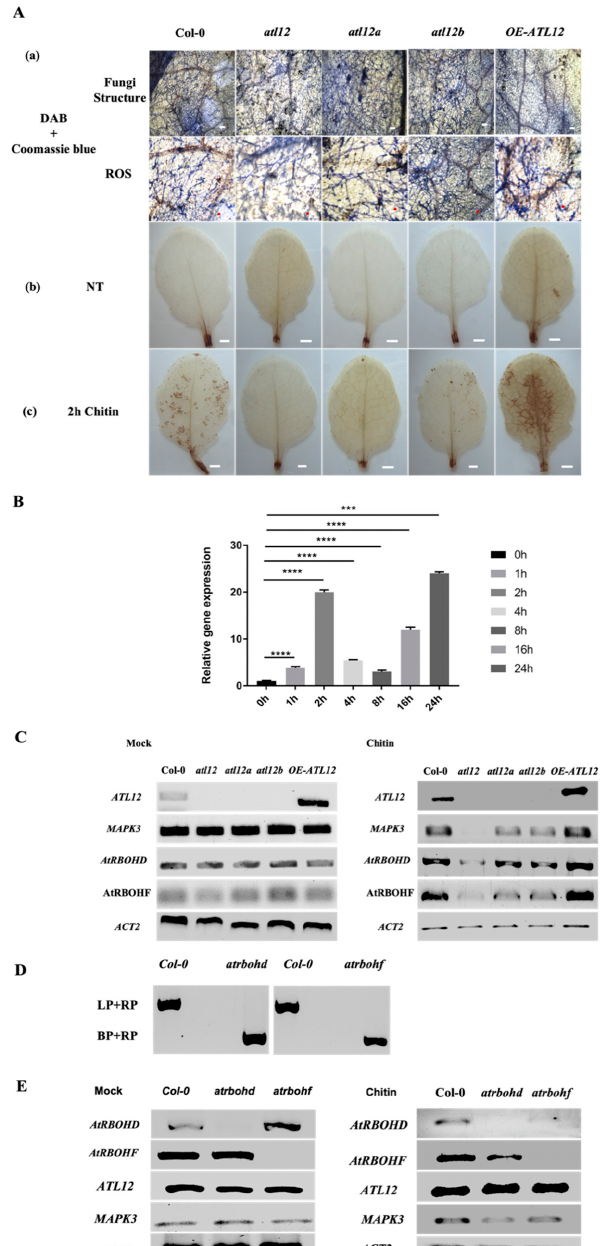
Figure 6. ATL12 is responsible for AtRBOHD/F -dependent ROS production in response to chitin. ( A ). ( a ) DAB and Coomassie blue staining of plants in response to fungal treatment. Blue line indicated fungal hyphae, and brown precipitate indicated ROS. ( b ) DAB staining of different seedlings without chitin treatment; ( c ) DAB staining of plants treated with 100 mg/mL chitin for 2 h. Scale bar indicated 1 mm. ( B ). Temporal expression level of AtRBOHD mRNA expression after chitin treatment via qRT-PCR. ( C ). RT-PCR analysis of ATL12 , MAPK3 , AtRBOHD , and AtRBOHF expression in wild-type, atl12 mutants and overexpression (OE) lines under normal condition(mock) and after chitin treatment. ( D ). Amplification of ATL12 in genomic DNA from the wild type, atrbohd and atrbohf . LP and RP are mutant-specific gene primers. BP is border primer in T-DNA insertional chunk in mutant. ( E ). RT-PCR analysis of AtRBOHD , AtRBOHF, ATL12 , and MAPK3 expression in mutant atrbohd , atrbohf , and Col-0 plants under normal conditions (mock control) and after chitin treatment. Experiments were repeated three times. The white and red scale bar indicates 1 mm. *** indicates p < 0.001 and **** indicates p <